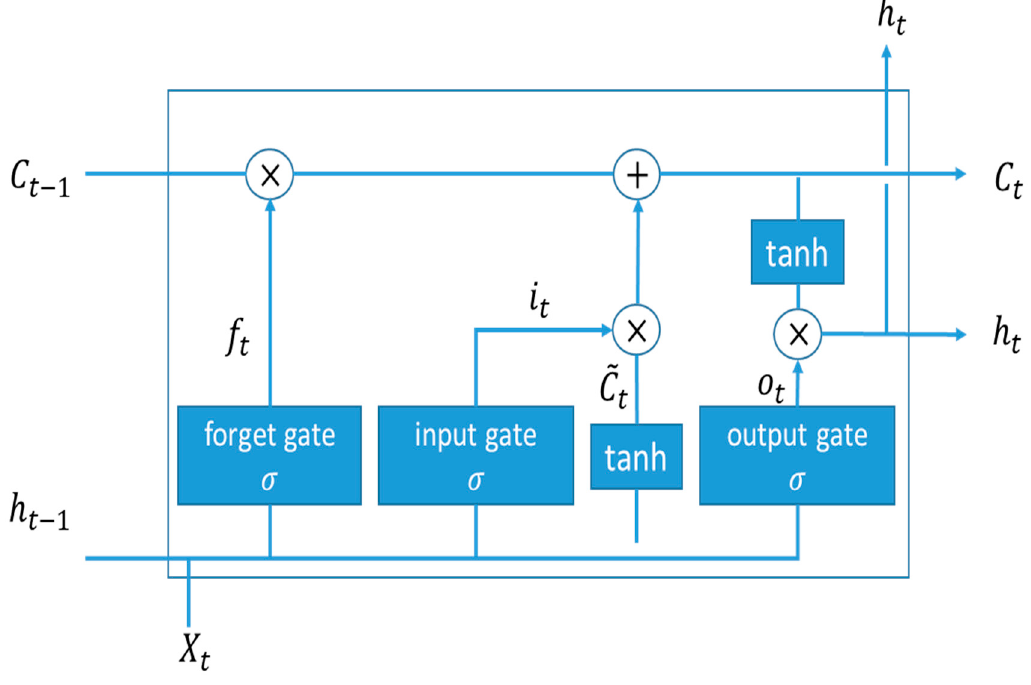
Figure 6. Basic structure of a long short-term memory (LSTM) model.